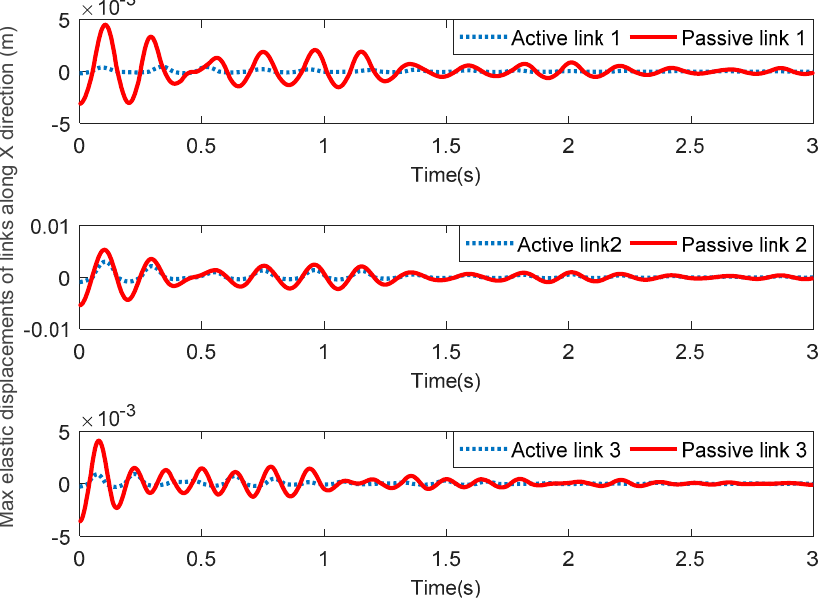
Figure 6. Maximum elastic displacements of active links and passive links along the X direction.